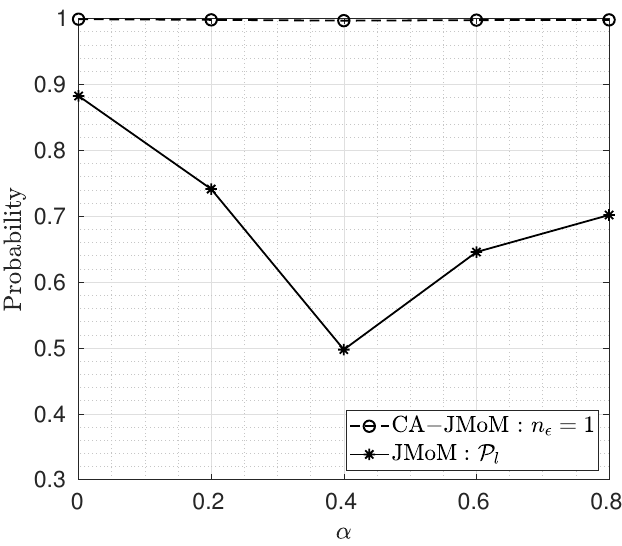
Figure 7. Lock-in probability for different coefficients in PDP estimation